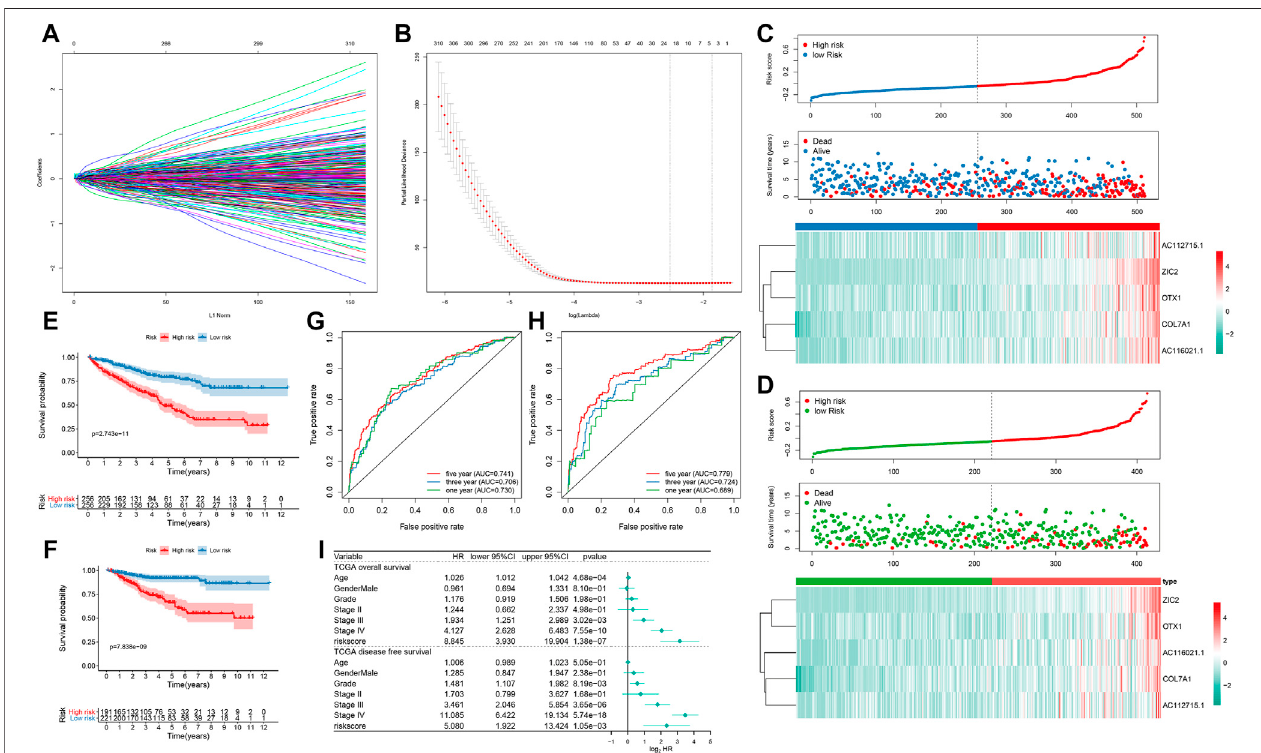
FIGURE7| Development ofaprognostic fi ve-genesignatureforccRCC inTCGA dataset (A) 20-timecross-validation fortuningparameterselectionintheLASSO Cox model (B) Plots of the LASSO coef fi cients (C) The risk score rank (up), distribution of survival status (alive or dead; middle) and expression patterns of fi ve genes in high- and low-risk groups (D) The risk score rank (up), distribution of survival status (diseased or disease-free; middle) and expression patterns of fi ve genes (down) in high-andlow-riskgroups (E,F) Kaplan-MeierOSandDFScurveforhigh-andlow-riskgroups (G) Time-dependent ROCcurvesforone-,three-and fi ve-yearsOS time (H) Time-dependent ROC curves for one-, three- and fi ve-years DFS time (I) Forest plots showing the multivariate Cox regression analyses results of the risk score and clinical factors with OS and